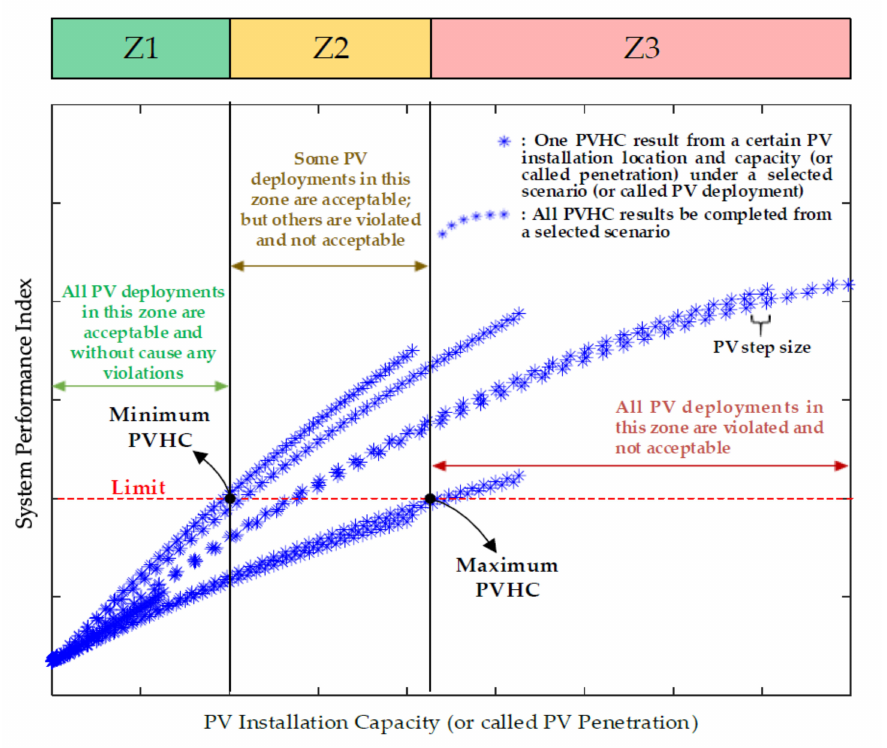
Figure 1. Schematic diagram of PV hosting